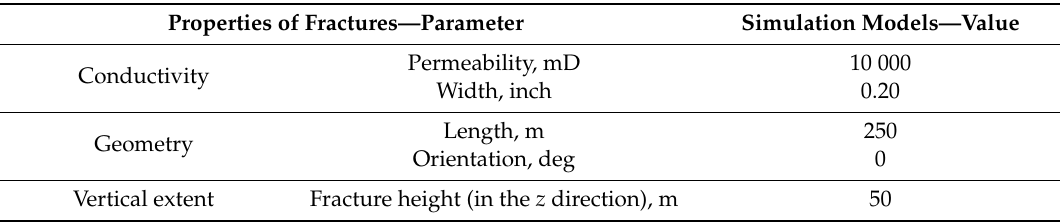
Table 5. Characteristics of fractures assumed in the simulation models.